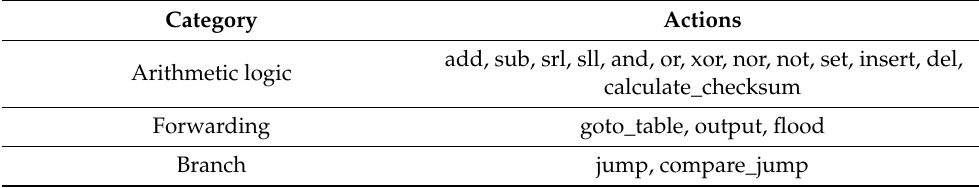
Table 3. Pipeline actions.